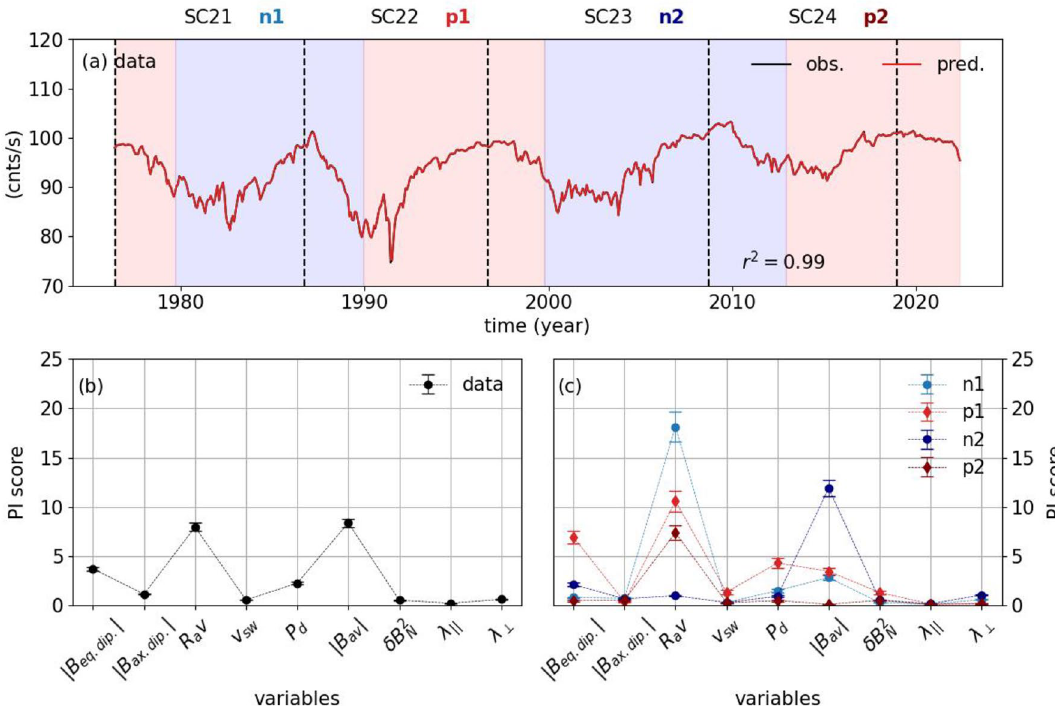
Figure 2. Panel ( a ) shows the LightGBM fit (red) plotted on the Newark NCRs (black). Permutation Importance scores for the unfiltered data for the past 4 solar cycles ( b ), and for the positive and negative polarity cycles ( c ). The blue and red shaded areas show when the HMF has negative and positive polarities, respectively. The vertical dashed lines indicate the solar minimum dates. We also note the solar cycles and the positive and negative polarity